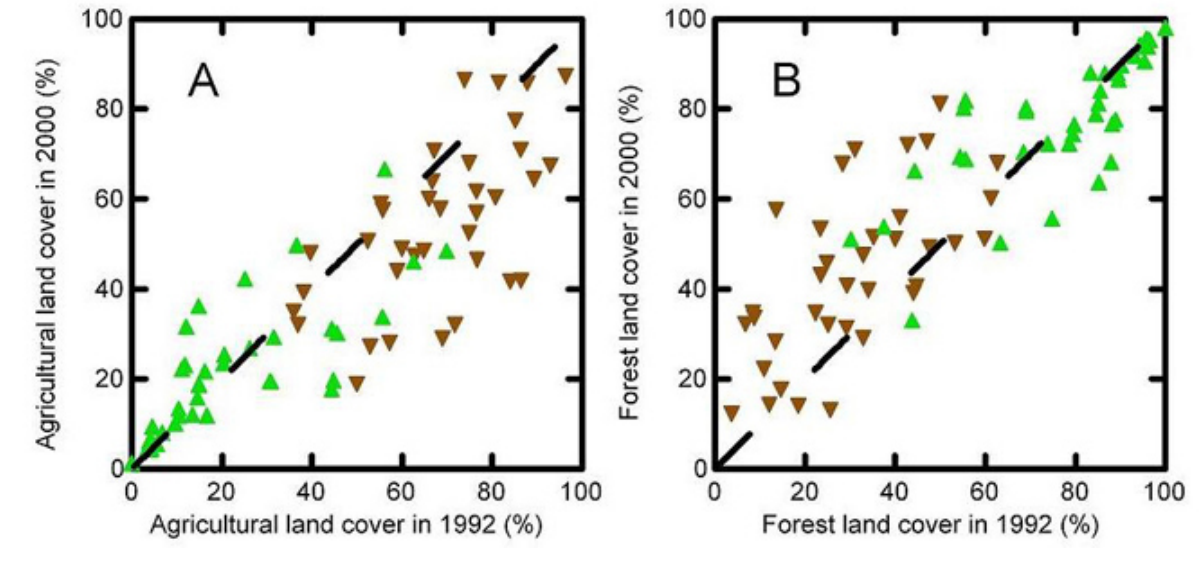
Fig. 5. The relationship between the 1992 and 2000 land cover in (A) agriculture and (B) forest in districts of Panama. The dashed line indicates a 1:1 relation. The amount of agricultural area tended to decrease and that of forested area tended to increase in districts that were largely deforested before 1947 (brown downward-pointing triangles). The amounts of agricultural and forested area tended to be relatively constant in districts that were deforested after 1947 (green upward-pointing